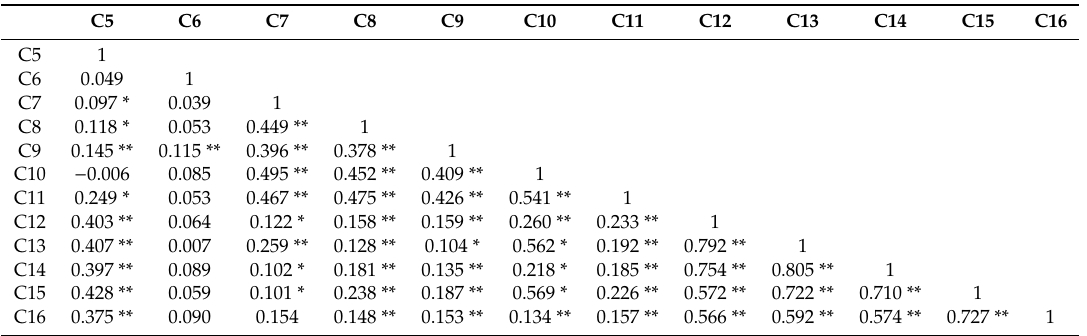
Table 6. Bivariate Pearson